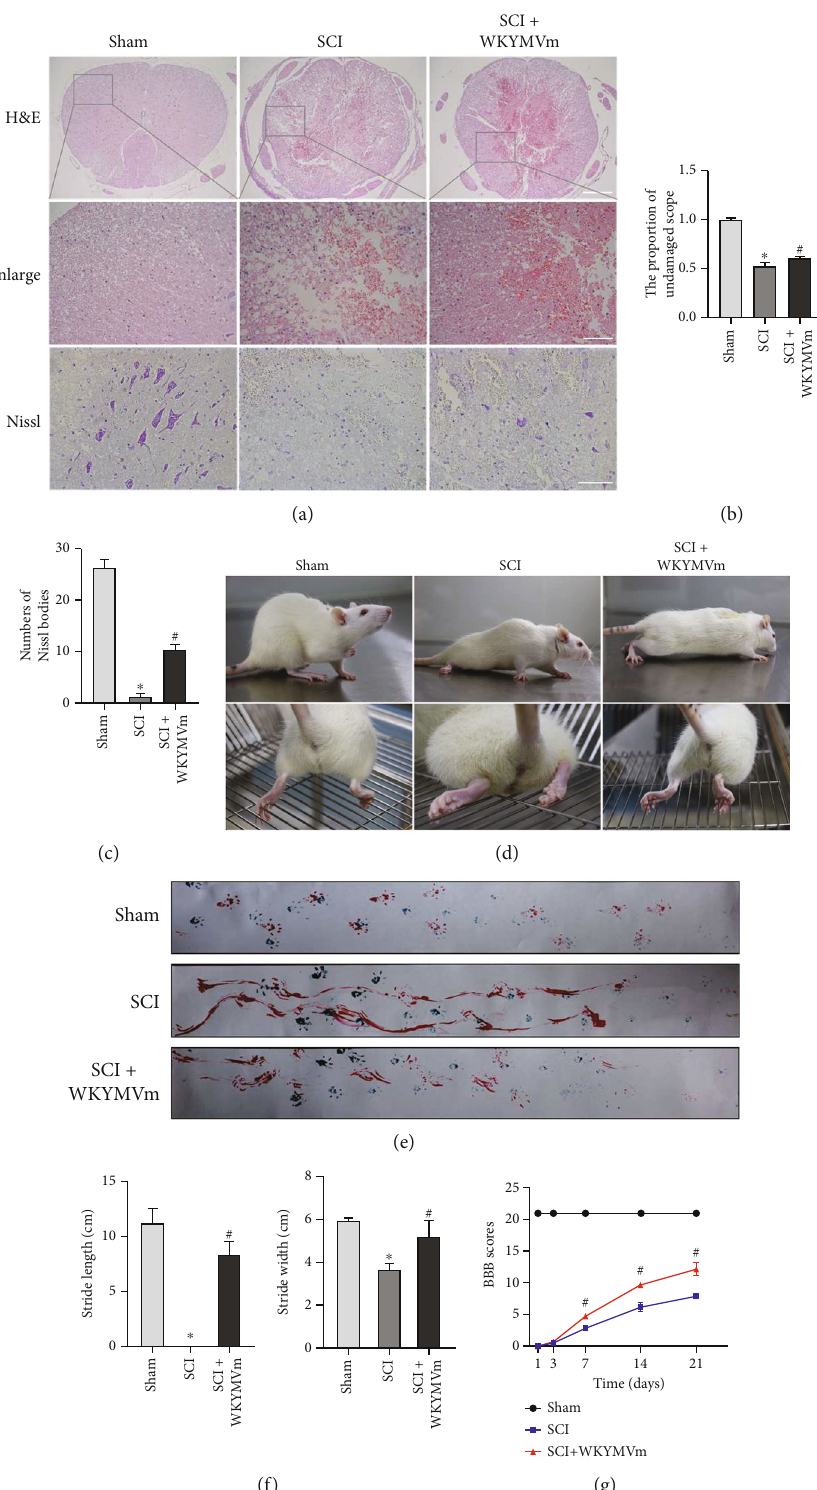
Figure 8: WKYMVm reduced tissue damage and functional decline after SCI. (a) Representative images from H&E and Nissl staining at 21 d after surgery. Quantitative data for (b) H&E and (c) Nissl staining. (d) Images displaying weight-bearing walking and hind limbs movements for the sham, SCI, and SCI+WKYMVm groups. Red arrows indicate weight-supported stepping. (e) The footprint analysis of rats from di ff erent groups. (f) Quanti fi cation of rats ’ stride length and stride width in footprint analysis. (g) Basso, Beattie, and Bresnahan (BBB) scores after surgery. Scale bars: 500 μ m (H&E); 200 μ m (enlarge); 100 μ m (Nissl). ∗ p < 0 : 05 vs. the sham group; # p < 0 : 05 vs. the SCI